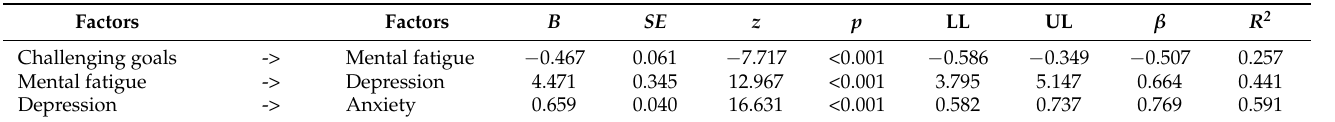
Table 17. Results of structural equation modeling of challenging goals, mental fatigue, depression, and anxiety in the group of participants of e-learning-based computer programming courses.